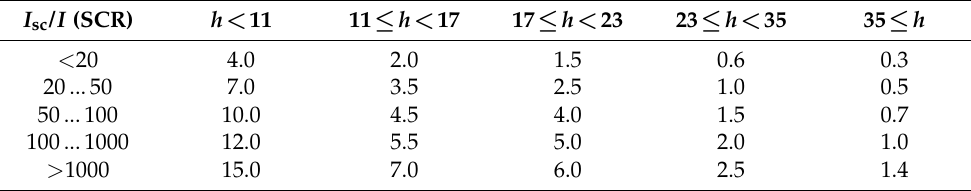
Table 2. IEEE 519 current harmonic limits for distribution systems with a 0.12–69kV nominal operating voltage [21]. The reported values refer to the maximum injected odd-harmonic current distortion in percent of I . Even-order harmonics are limited to 25% of the odd-harmonic limits. I sc / I (SCR) h < 11 11 ≤ h < 17 17 ≤ h < 23 23 ≤ h < 35 35 ≤